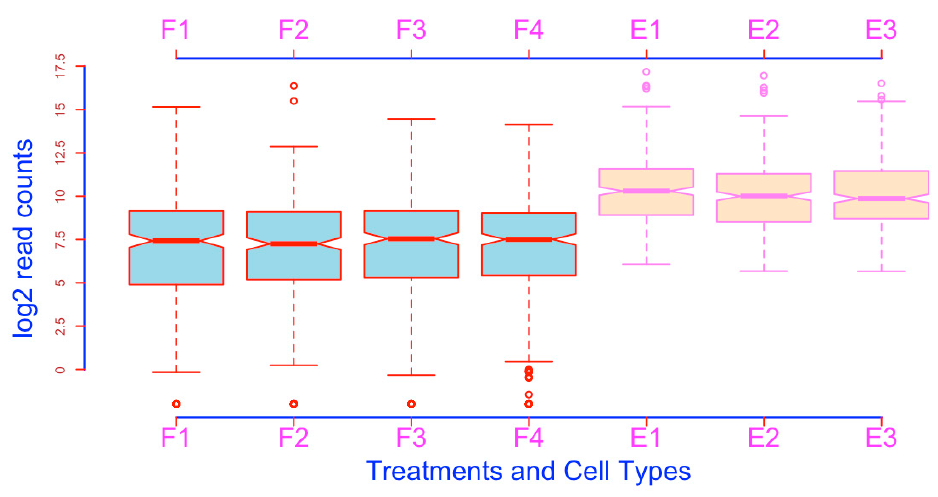
Figure 28. Add an x-axis above the boxplots.